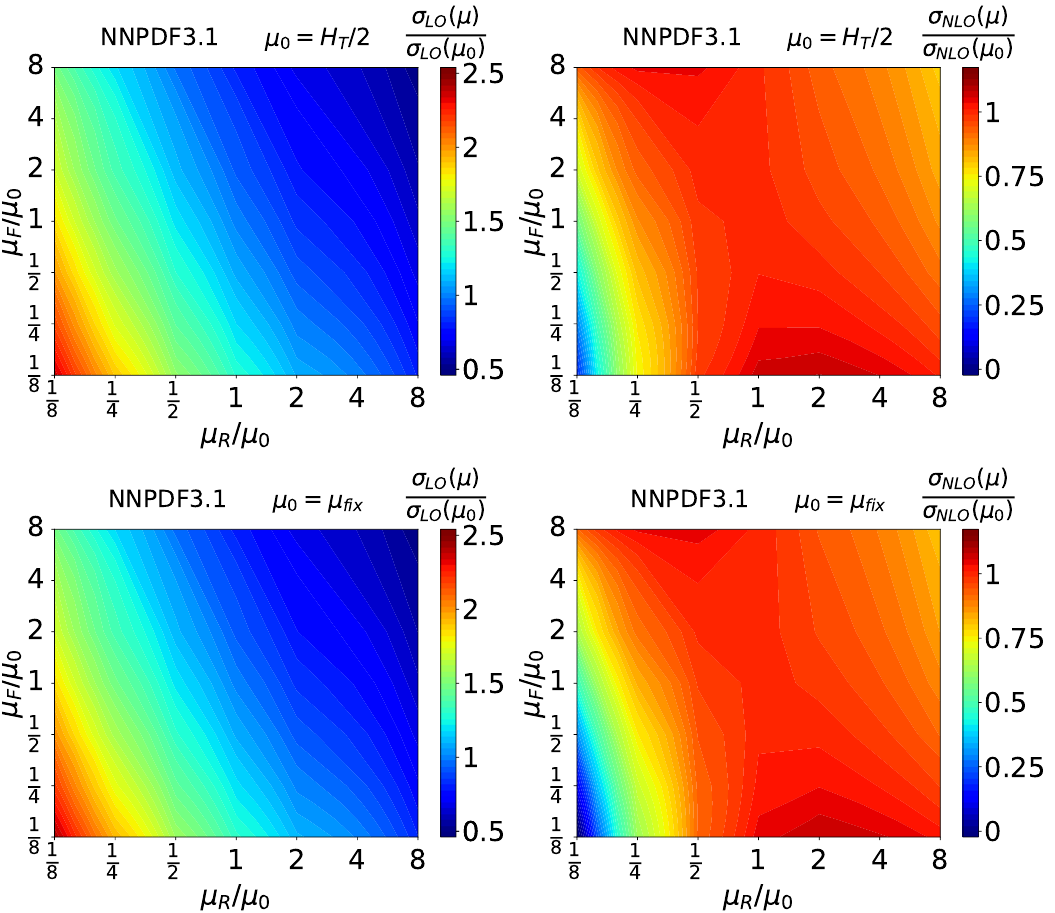
Figure 4 . Contour plots for the scale dependence in the µ R − µ F plane at LO (left) and NLO (right) for the pp → e + ν e µ − ¯ ν µ b ¯ b H process at the LHC with µ 0 = H T / 2 and µ 0 = µ fix as well as for the NNPDF3.1 PDF